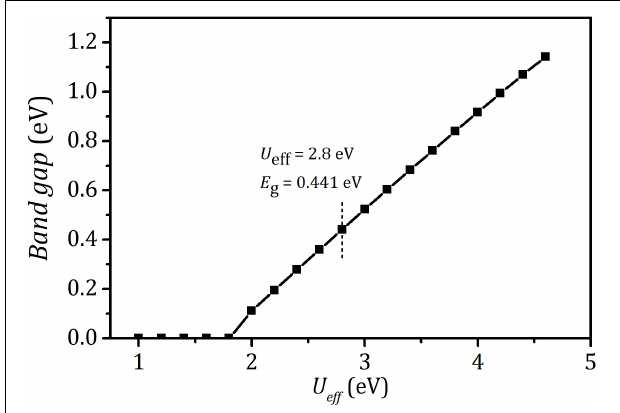
FIGURE 1 | Bandgap of bulk LaCoO 3 as a function of effective coulomb-exchange interaction parameter U eff (1.0–4.6